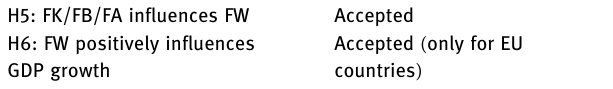
Table 9: Descriptive statistics for items in H1 to H4, regarding gender for Non - EU countries